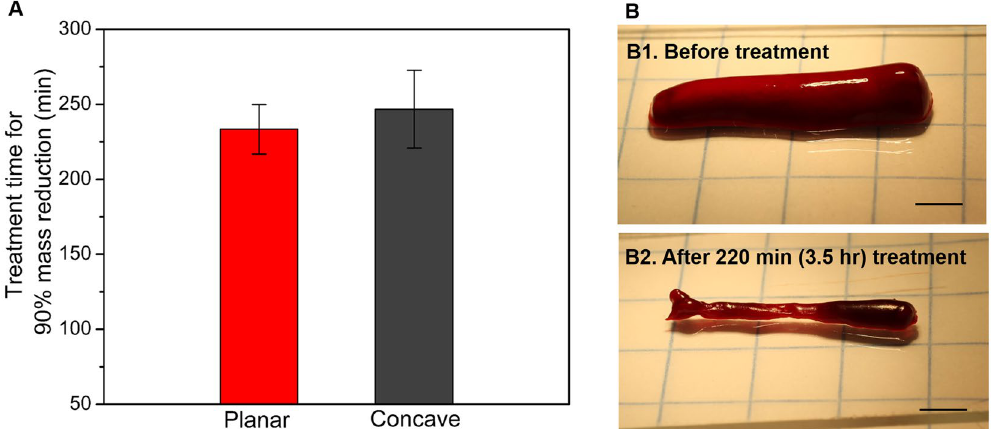
Figure 5. In vitro test result for complete mass reduction. ( A ) Required treatment time for 90% mass reduction of 200 mg clot samples with the treatment conditions of 80 V pp input voltage, 10% duty cycle, and 10 7 bubbles/ ml injection with 100 μ l/min flow rate (n = 3). The difference of treatment time between planar and concave prototypes showed no statistical significance. ( B ) A 200 mg clot sample decreased in volume and mass after 3.5 hr treatment (scale bar = 3 mm). The remaining small (~20 mg) fibrin (B2) was not completely removed by continued treatment ( > 4.5